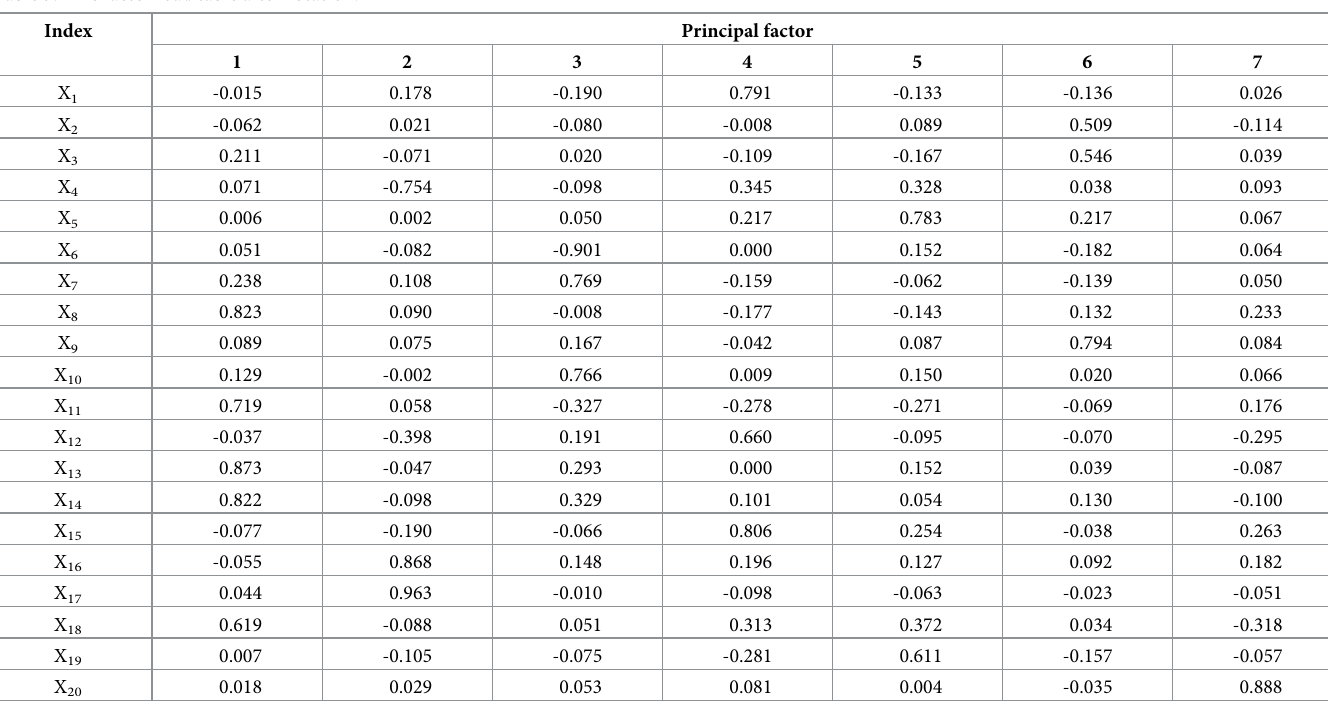
Table 5. The factor load table after rotation.